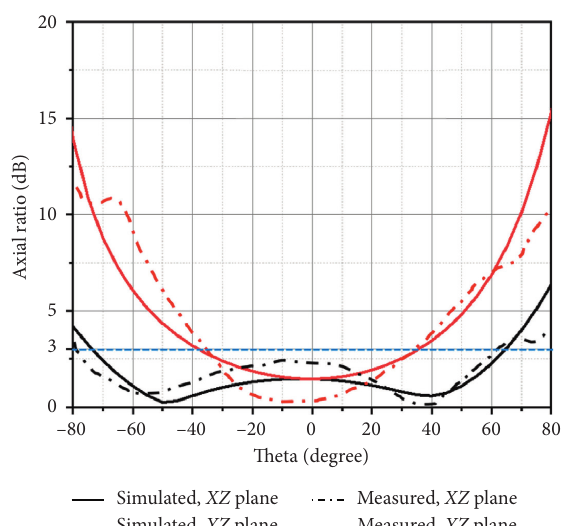
Figure 9: Simulated and measured AR as a function of θ angle from the broadside, in the XZ and YZ planes at